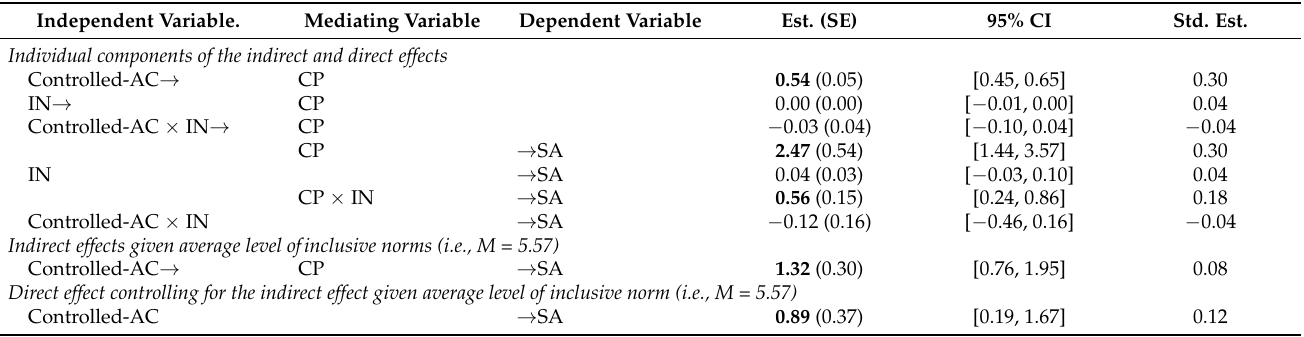
Table 4. Results of the Moderated Mediation Analysis for Controlled-Appetitive Cyberaggression (Controlled-AC): Indirect and Direct Effects Moderated by Inclusive Norms